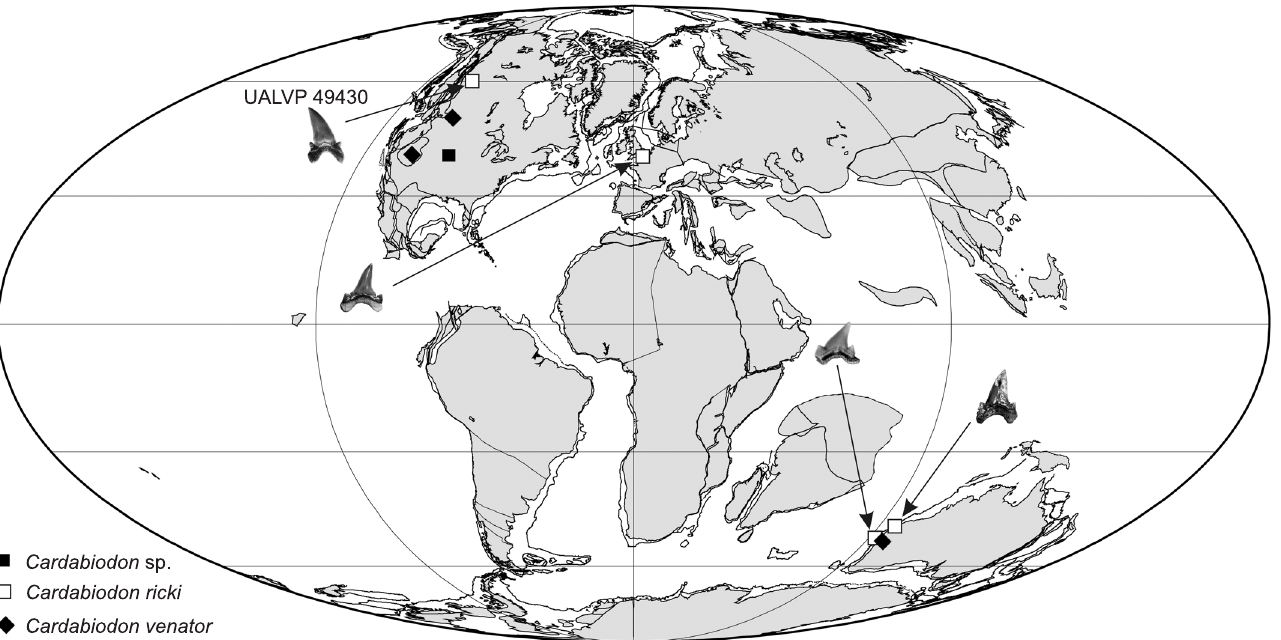
Fig. 1. Early Late Cretaceous map (90 Ma; PLATES Program 2009) showing locations of fossil localities (late Cenomanian to middle Turonian) yielding Cardabiodon spp. (see Cook et al. 2010). UALVP 49430 from Canada is likely a transitional morphotype between Cardabiodon ricki and Cardabiodon venator